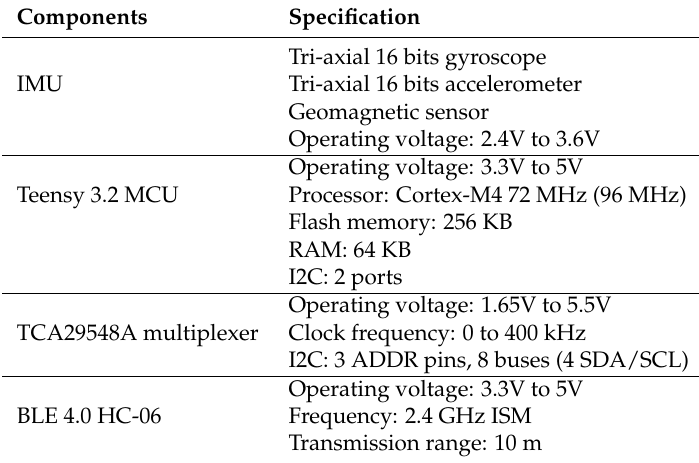
Table 2. Components in a sensing